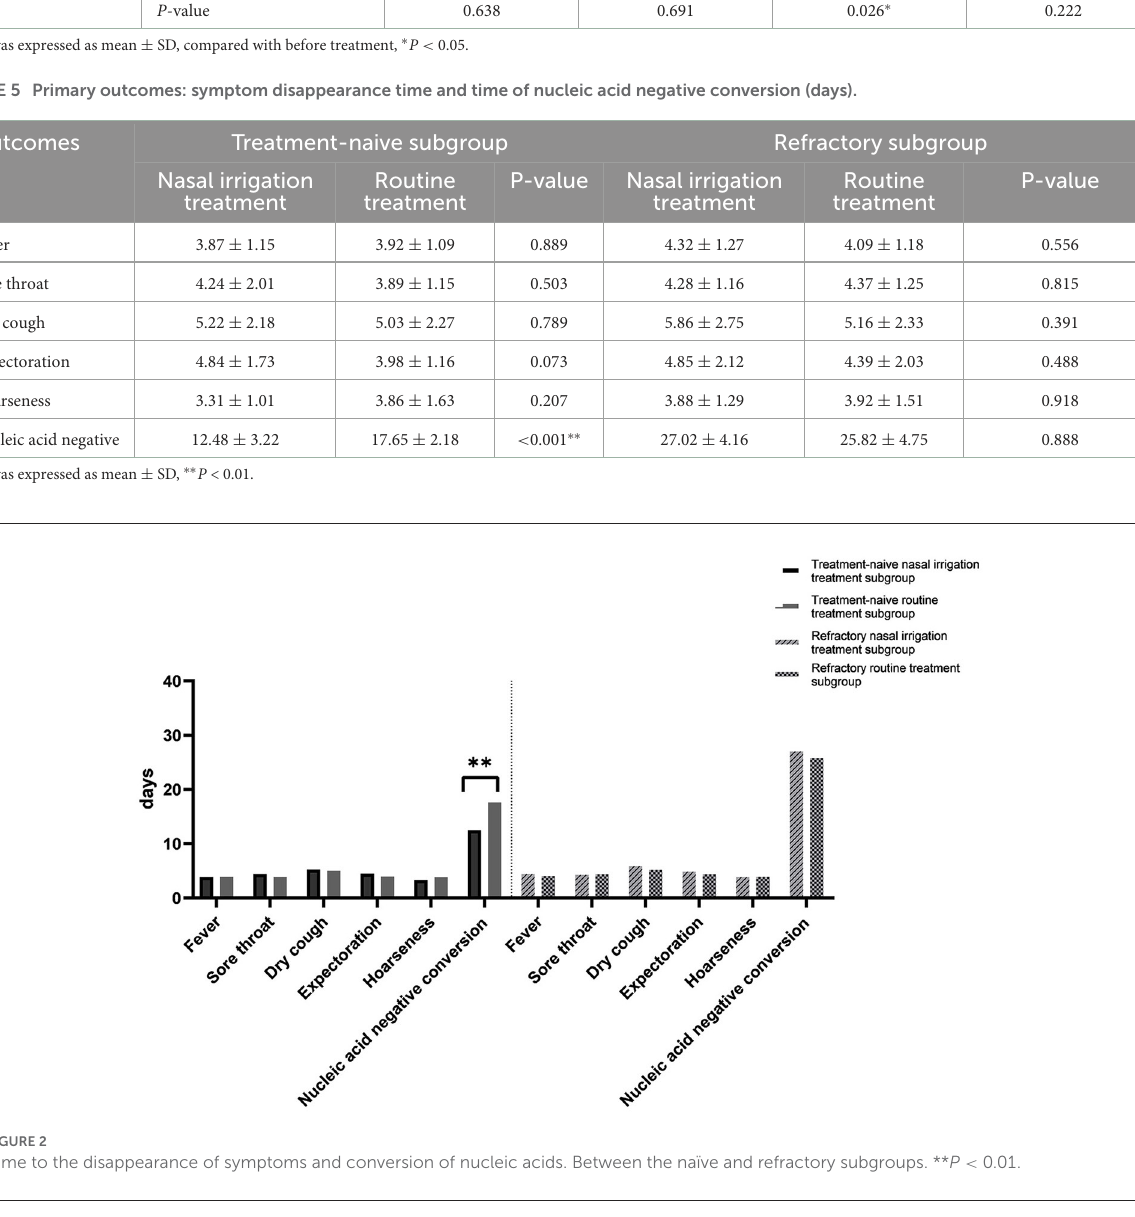
had lower LYM count, and the LYM count improved when the COVID-19 nucleic acid turned negative. In